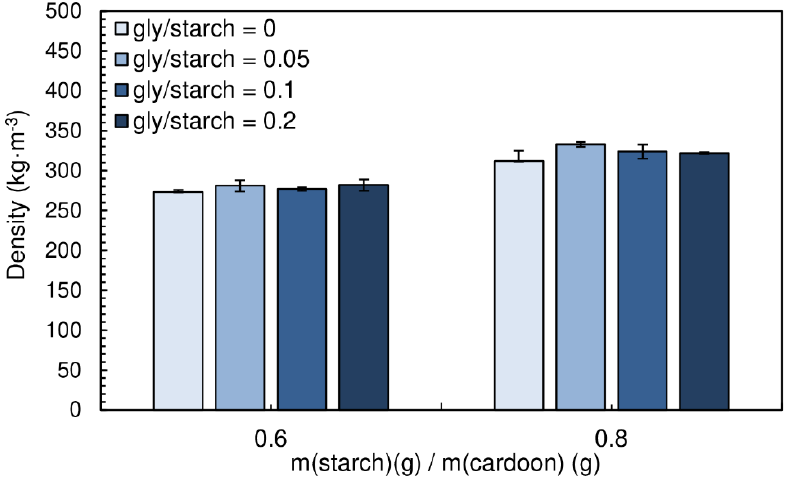
Figure 9. Density of the particleboards produced with different gly/starch ratios. All adhesive formulations had a starch/cardoon ratio of 0.6 and 0.8 and cs/starch ratio of 0.05.